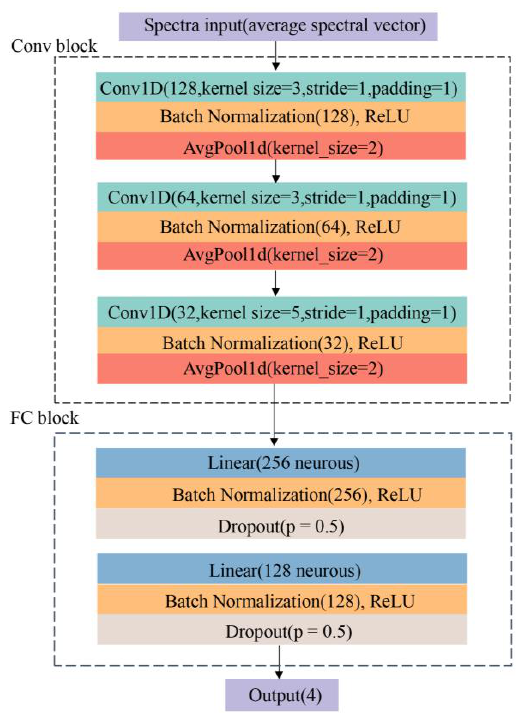
Figure 3. The proposed convolutional neural network (CNN) structure for the identification of pes- ticide residues in grapes. pesticide residues in